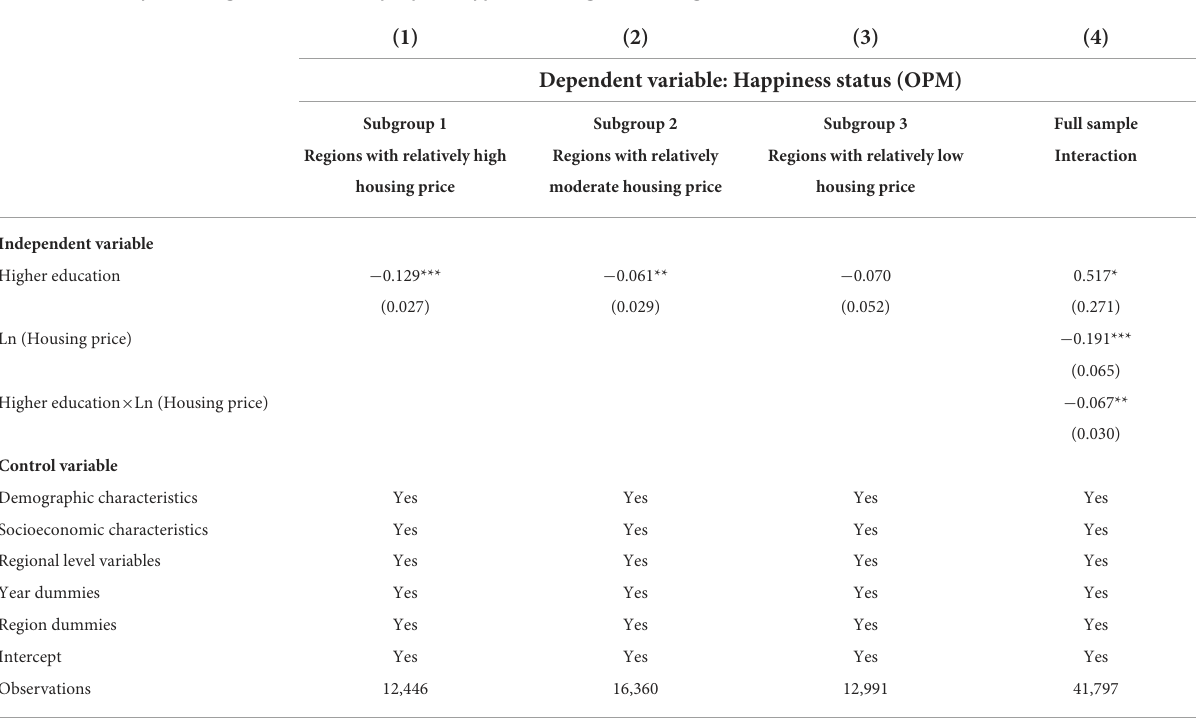
TABLE 10 The impacts of higher education on people’s happiness among different regions.